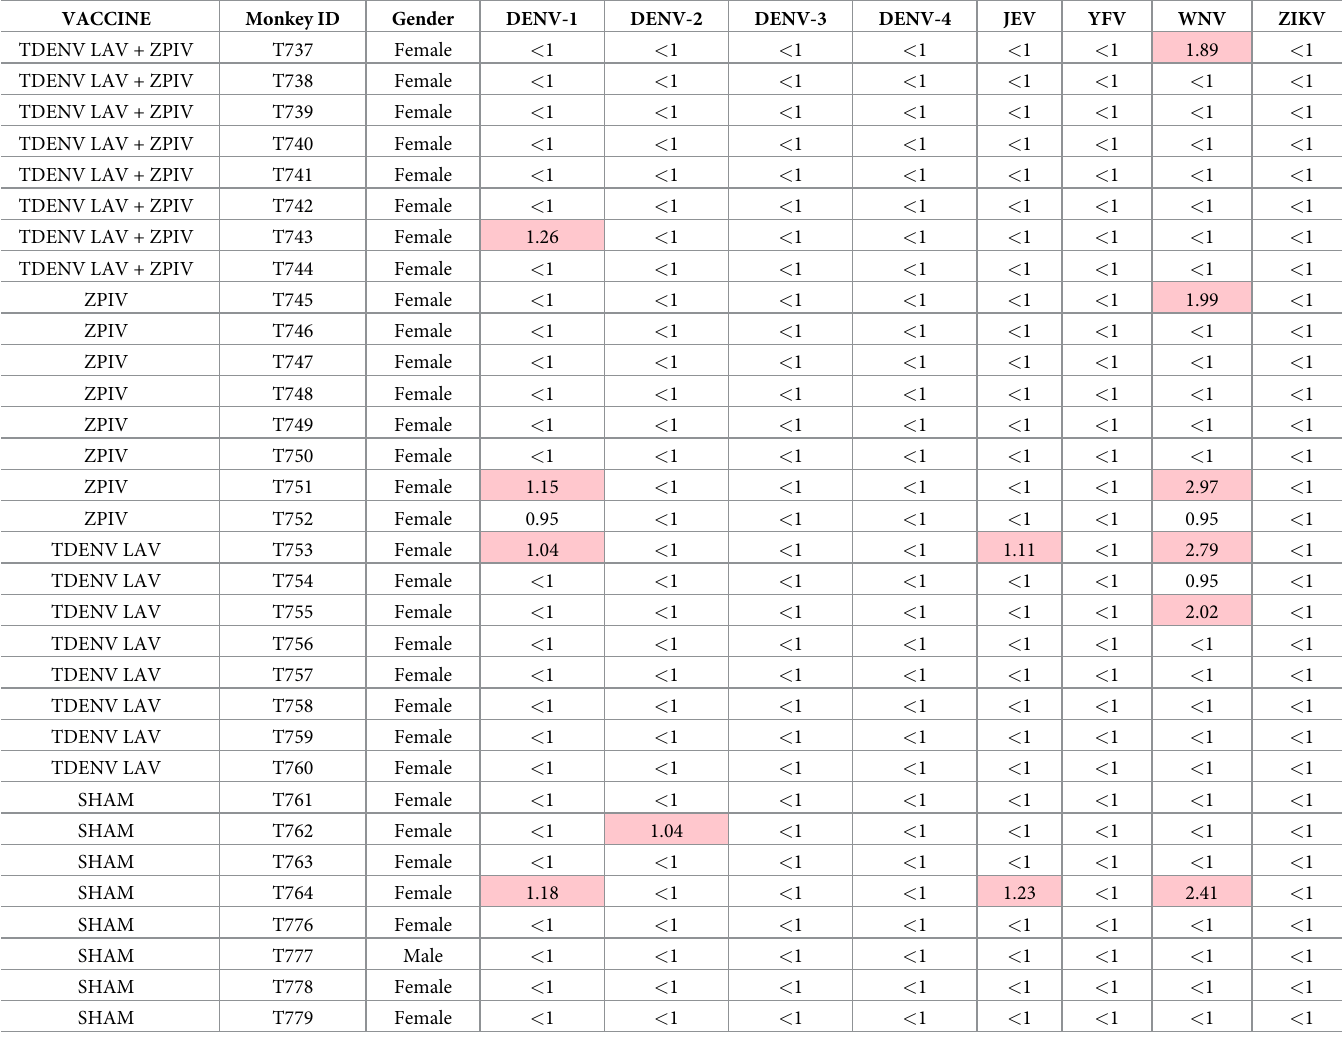
Table 1. Log titer of previous flavivirus seropositivity in animals used in this study. VACCINE Monkey